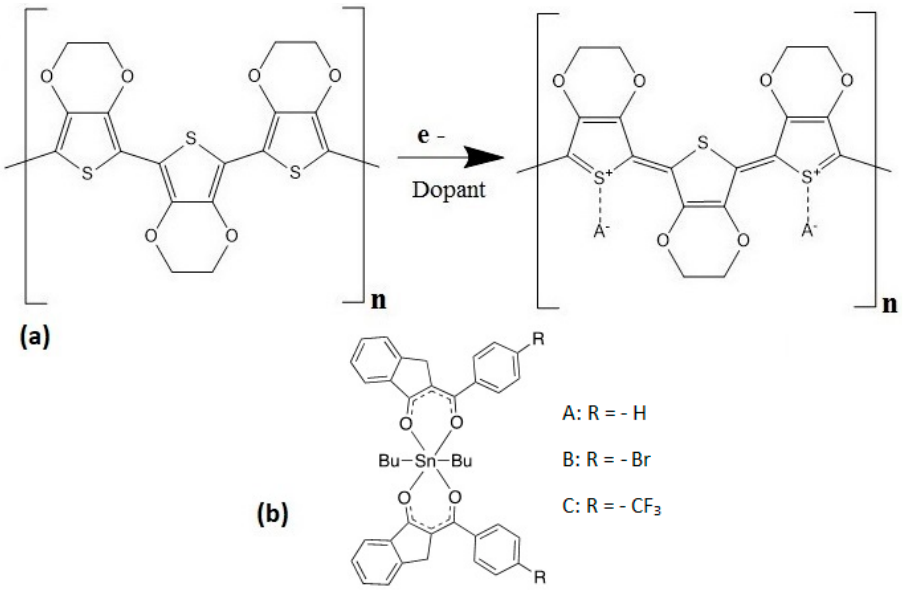
Figure 1. Structures of ( a ) PEDOT and ( b ) organotin (IV)